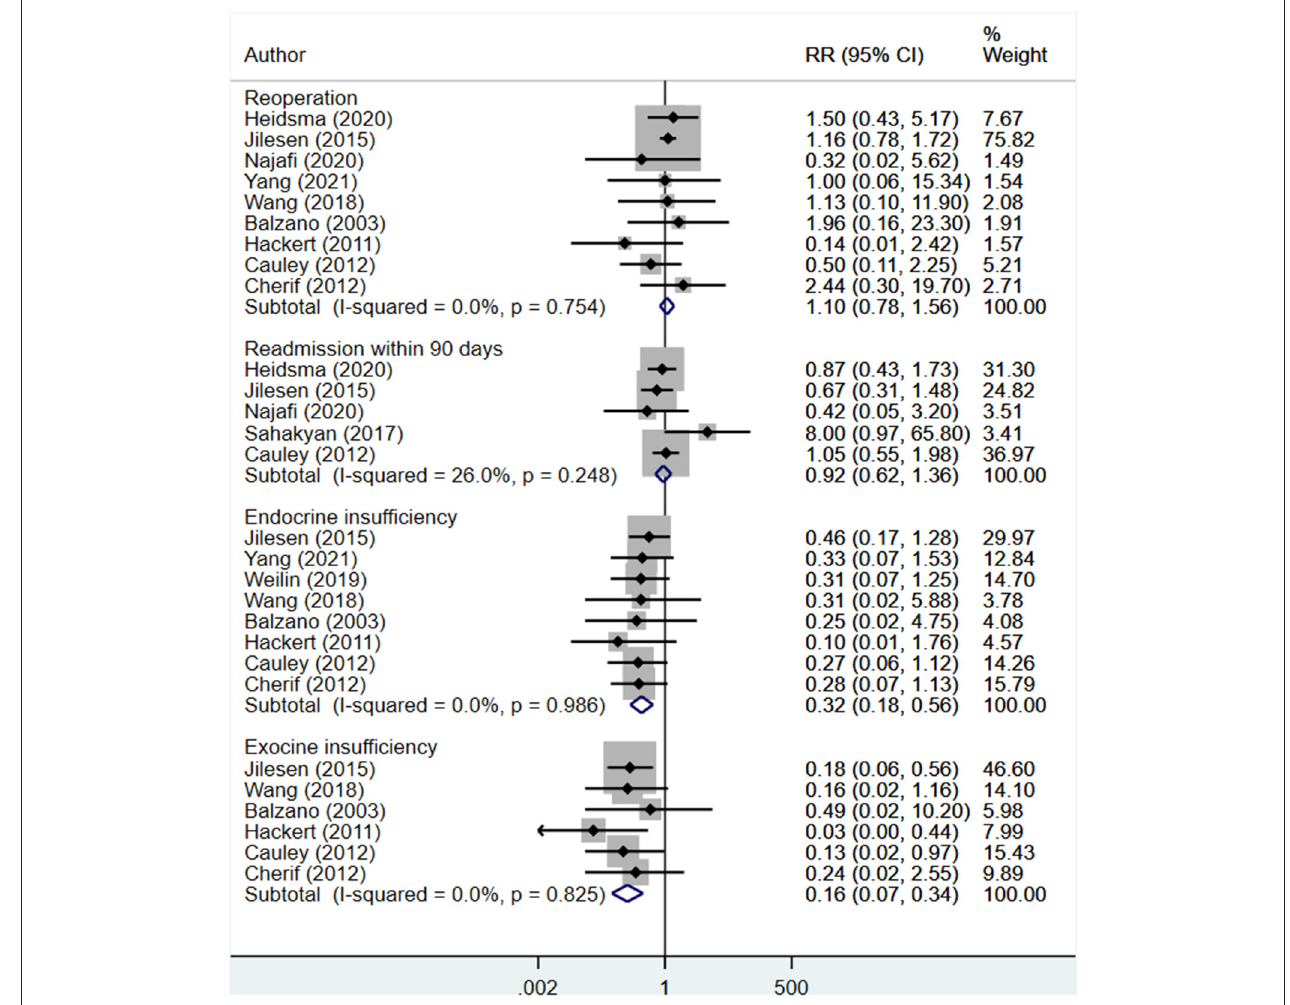
FIGURE 5 | Comparison of risk of reoperation, readmission, endocrine insufficiency and exocrine insufficiency between enucleation and standard surgical